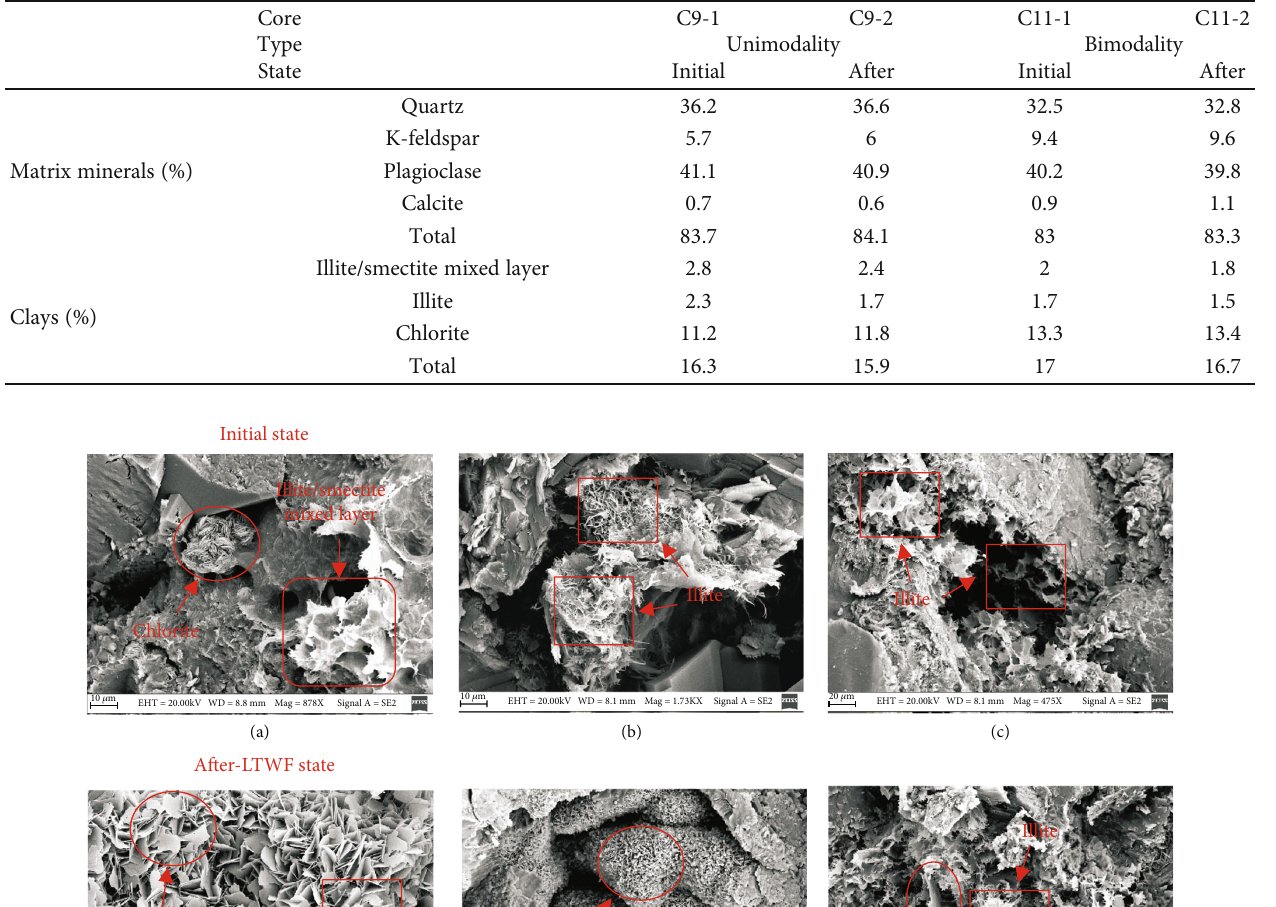
Table 6: Comparison of matrix minerals and clays between initial state and after-LTWF state.